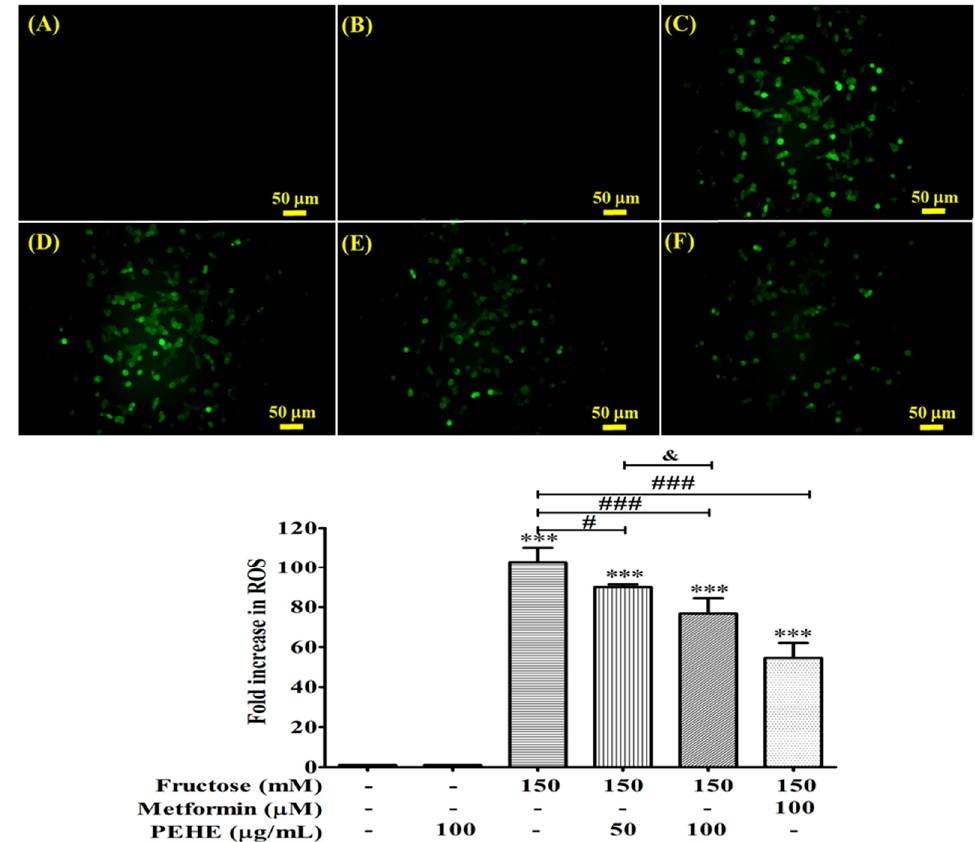
Figure 4. Intracellular ROS induced by fructose and attenuated by PEHE. RINm5F β - cells were pretreated with or without fructose (150 mM) for 2 h before exposure to PEHE (50 and 100 µ g/mL) for 24 h. Intracellular reactive oxygen species were stained with DCFH- DA and assessed via phase contrast fluorescence microscopy [upper panel, original magnifi- cation ( × 100); ( A ) control, ( B ) PEHE (100 µ g/mL) treatment only, ( C ) fructose (150 µ g/mL) treatment only, ( D ) fructose + PEHE (50 µ g/mL), ( E ) fructose + PEHE (100 µ g/mL) and ( F ) fructose + metformin (100 µ g/mL)]. One-way ANOVA was followed by Tukey’s post hoc test. Values are expressed as mean ± standard deviation (bottom panel, n = 3). *** p < 0.001 vs. the control group; # p < 0.05 and ### p < 0.001 vs. the fructose